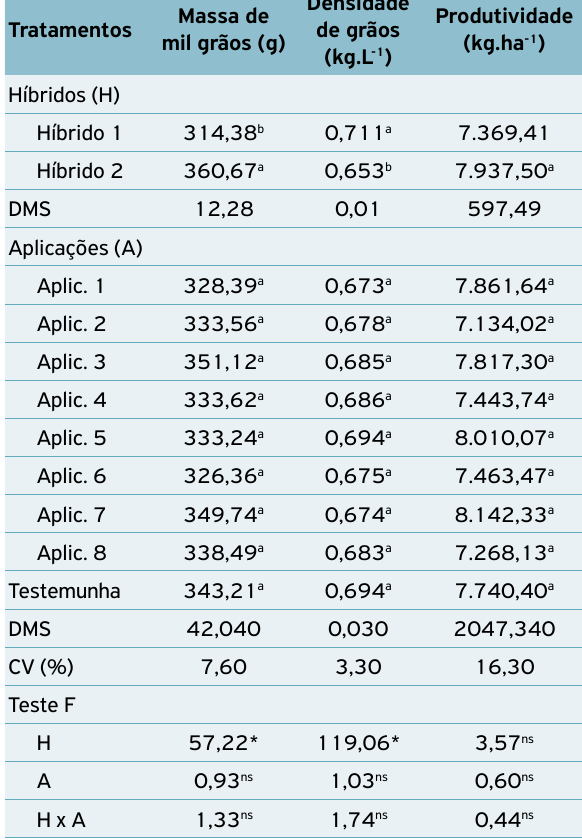
Tabela 4. Valores médios referentes a massa de mil grãos, densidade de grãos e produtividade para híbridos e aplicações de piraclostrobina. Jataí, Goiás,